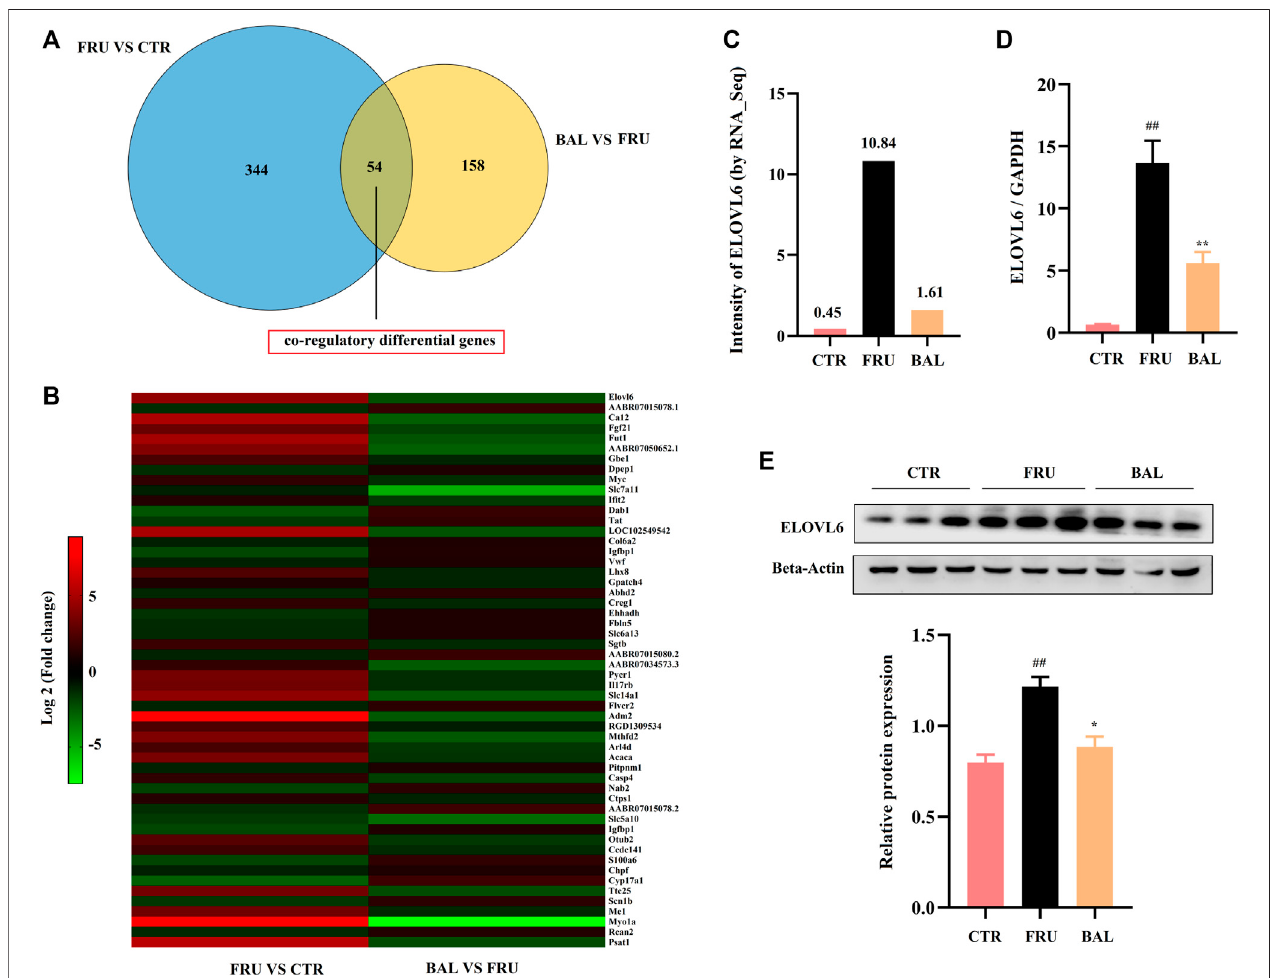
FIGURE 3 | RNA-sequencing analysis and veri fi cation. (A) Venn analysis of differentially expressed genes. (B) Heat-map of co-regulatory differentially genes. (C) Intensity of ELOVL6 in RNA-Sequencing analysis. (D) RT-qPCR analysis of ELOVL6 in rat liver. (E) ELOVL6 protein expression in liver by western- blot. Data were represented as Mean ± SEM ( n = 6/group), ## p < 0.01 , # p < 0.05 , compared with CTR; **p < 0.01 , *p < 0.05 , compared to FRU.